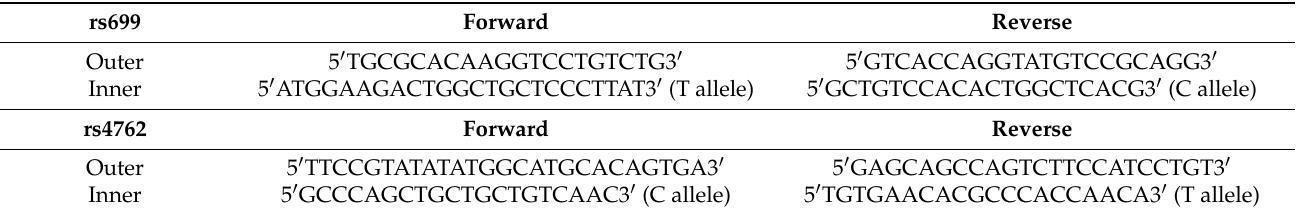
Table 1. Primer sequences for rs699 and rs4762 detection using tetra primers amplification-refractory mutation system